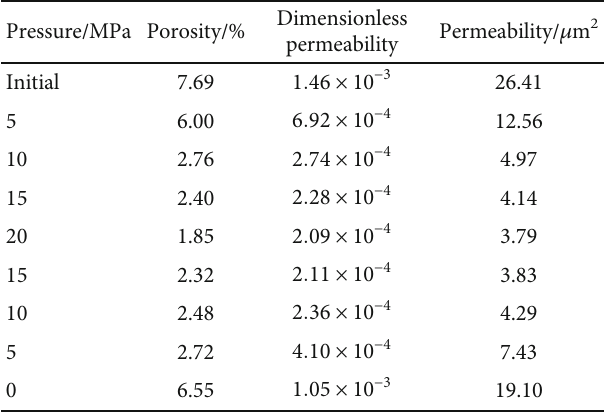
Figure 6: The images of streamlines in the porous sample. Table 2: LBM-simulated permeability data for porous